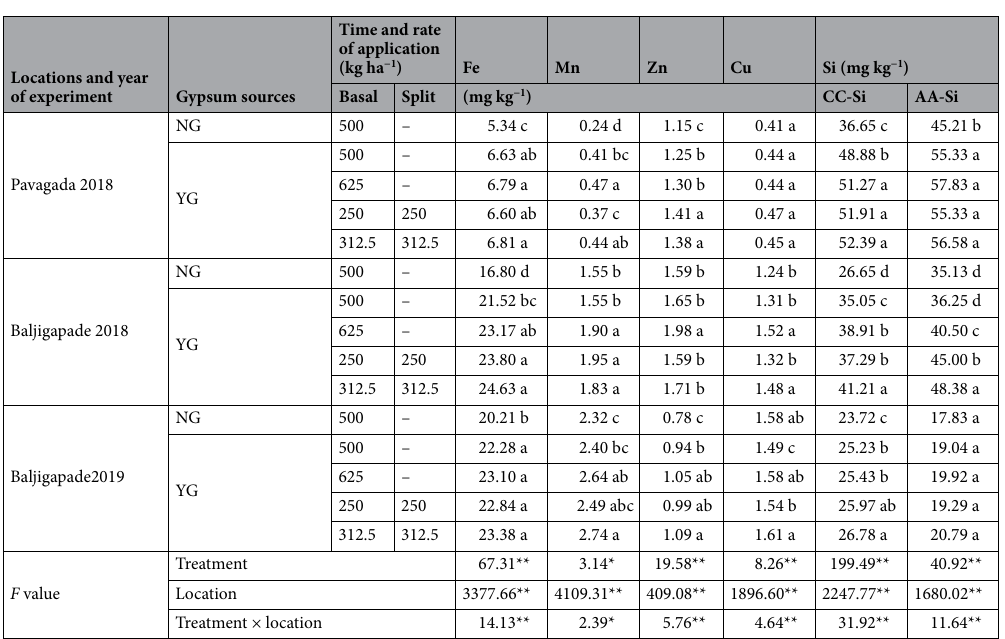
Table 4. Effect of different sources, time and rate of application of gypsum on DTPA—extractable micronutrients and silicon in post-harvest soils of Pavagada (2018) and Baljigapade (2018 and 2019). F value and significance level (**P < 0.01, *P < 0.05 and ns P ≥ 0.05). Values followed by a different letter within the same column and the same year are significantly different at P < 0.05 probability level. YG yellow gypsum, NG natural gypsum, CC-Si